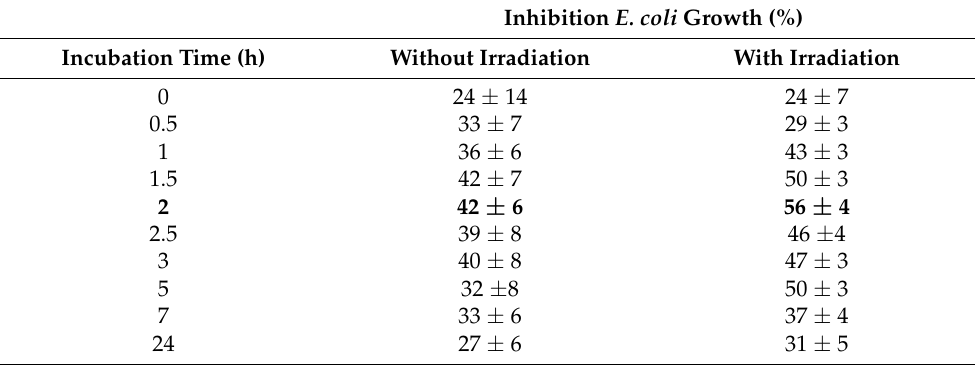
Figure 5. Inhibition of Escherichia coli growth. ( a ) Percentage of growth was calculated for E. coli incubated with ND-mTHPP (100 µ g/mL) and E. coli incubated with Ampicillin (100 µ g/mL), in Mueller Hinton Broth Medium (MHB), with and without irradiation at different time after the irradiation. ( b ) Percentage of growth was calculated for E. coli incubated with ND-mTHPP (100 µ g/mL) and E. coli incubated with Ampicilin (100 µ g/mL), in Mueller Hinton Broth Medium (MHB), with irradiation. Experiments were performed in triplicate and significant differences between E. coli control and test samples are marked with * ( p < 0.05), ** ( p < 0.01), and *** ( p < 0.001). Table 2. Inhibition of Escherichia coli growth by ND-mTHPP, with and without irradiation, calculated from 0 to 24